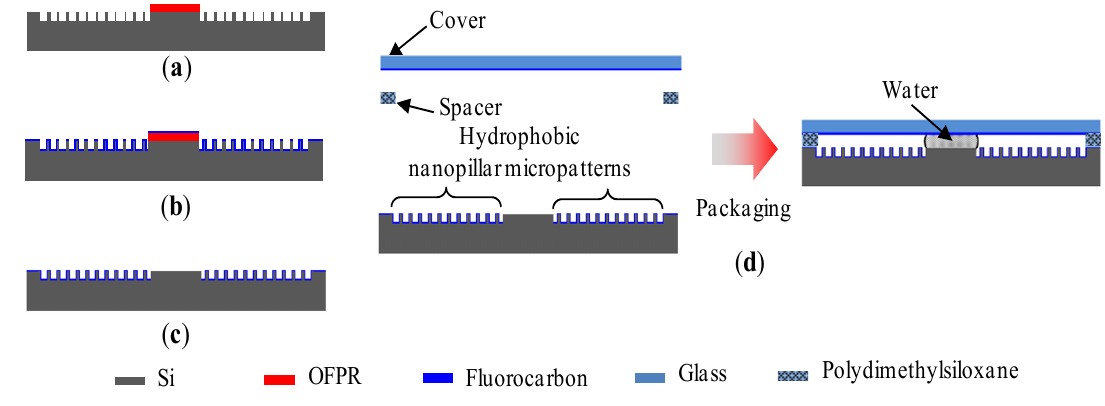
Figure 6. Fabrication of surface-directed liquid flow. ( a ) Patterning of OFPR as the sacrifice layer, ( b ) deposition of fluorocarbon, ( c ) removal of OFPR and ( d ) packaging and introduction of